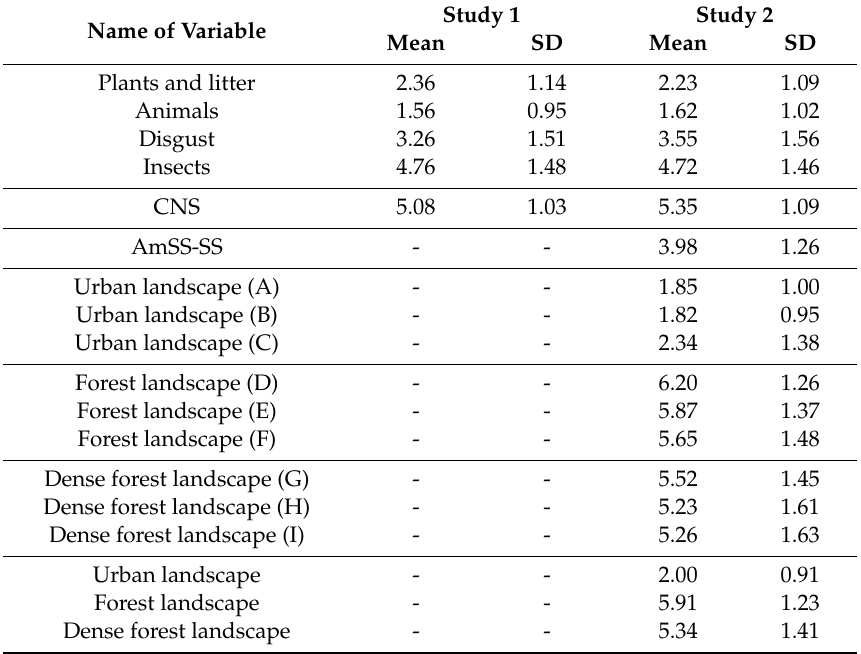
Table 2. Means and standard deviations of each scale and subscale and mean preferred pleasantness for each